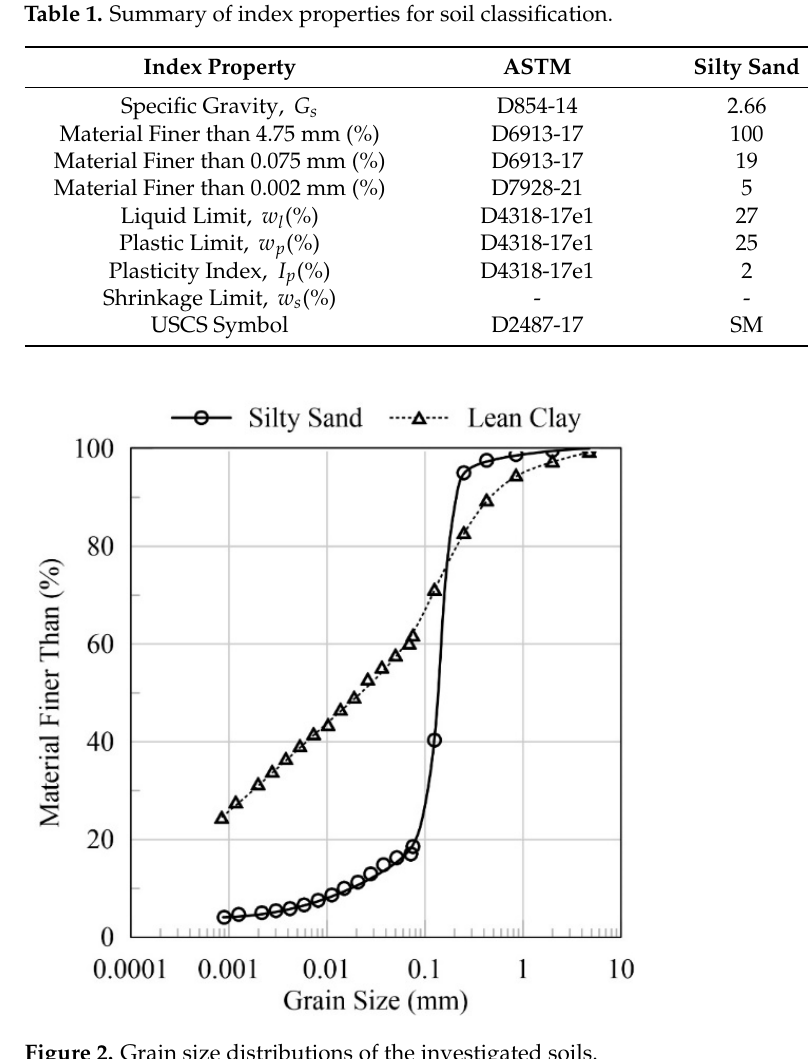
Table 1. Summary of index properties for soil classification.